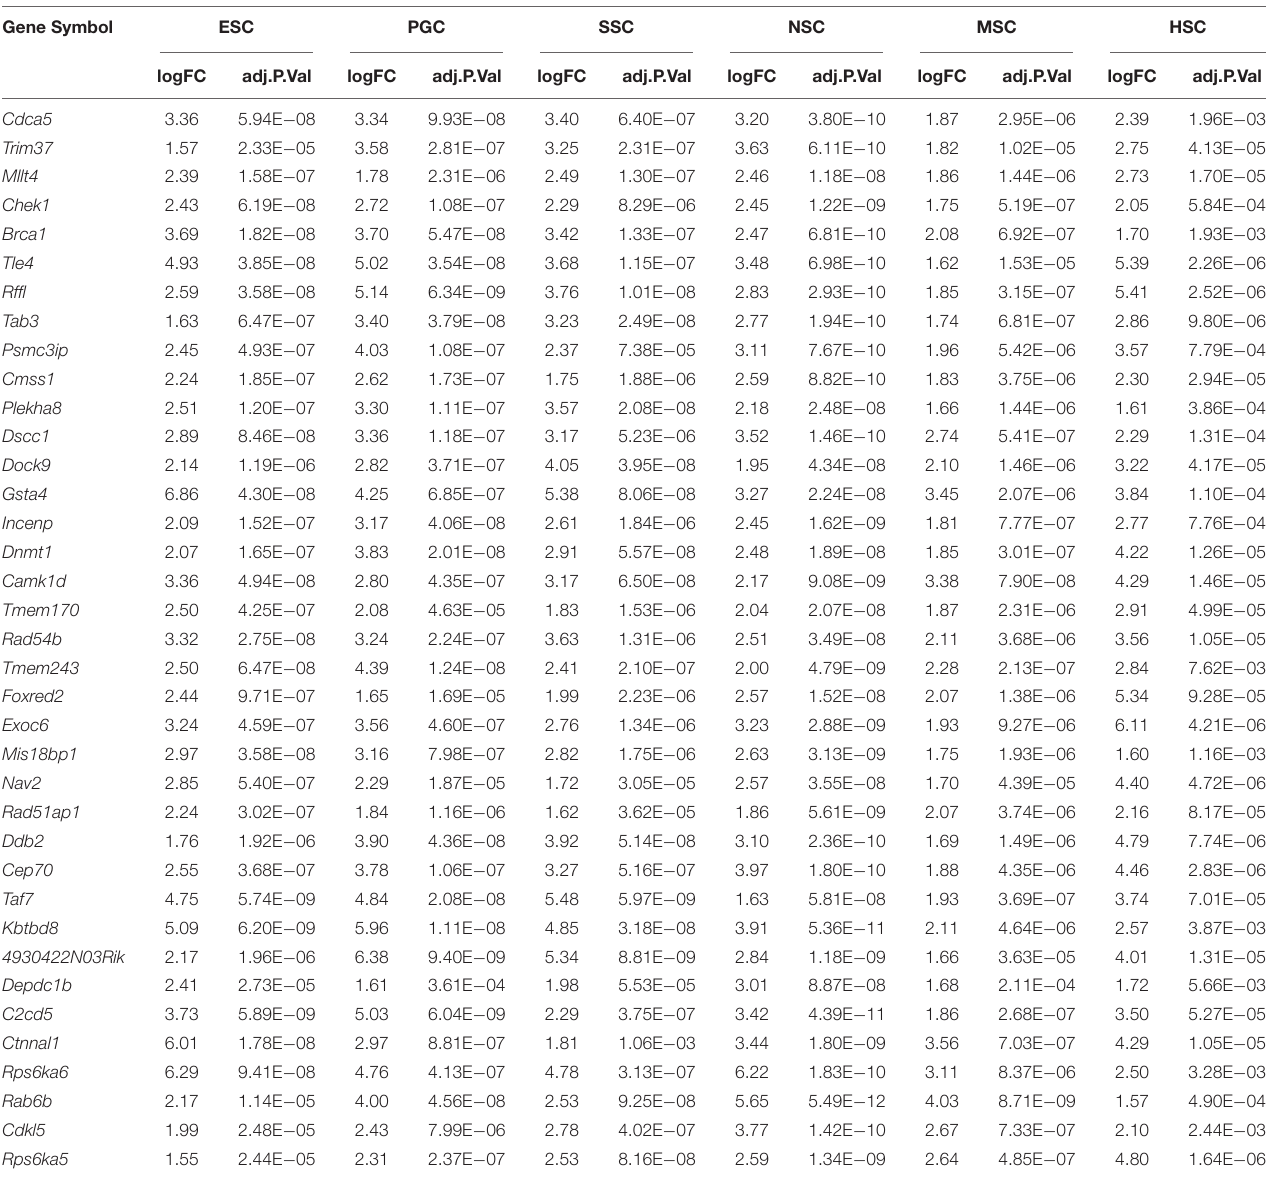
TABLE 1 | The 37 core highly expressed